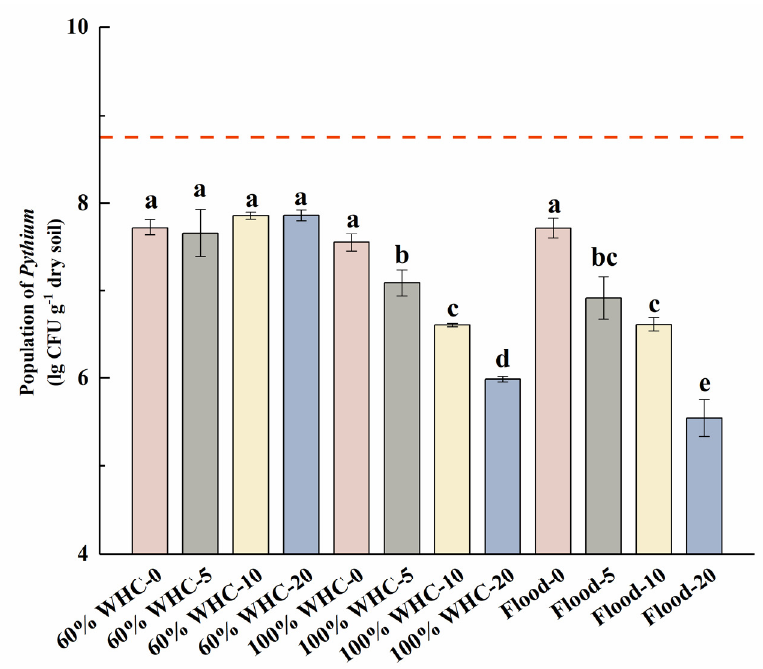
Figure 5. The population of F. oxysporum in soils after RSD treatments through real-time PCR. Error bars indicate standard deviations. Different lowercase letters show significant differences among the various treatments (SNK tests, p < 0.05). The dashed lines represent the initial value of the original soil.